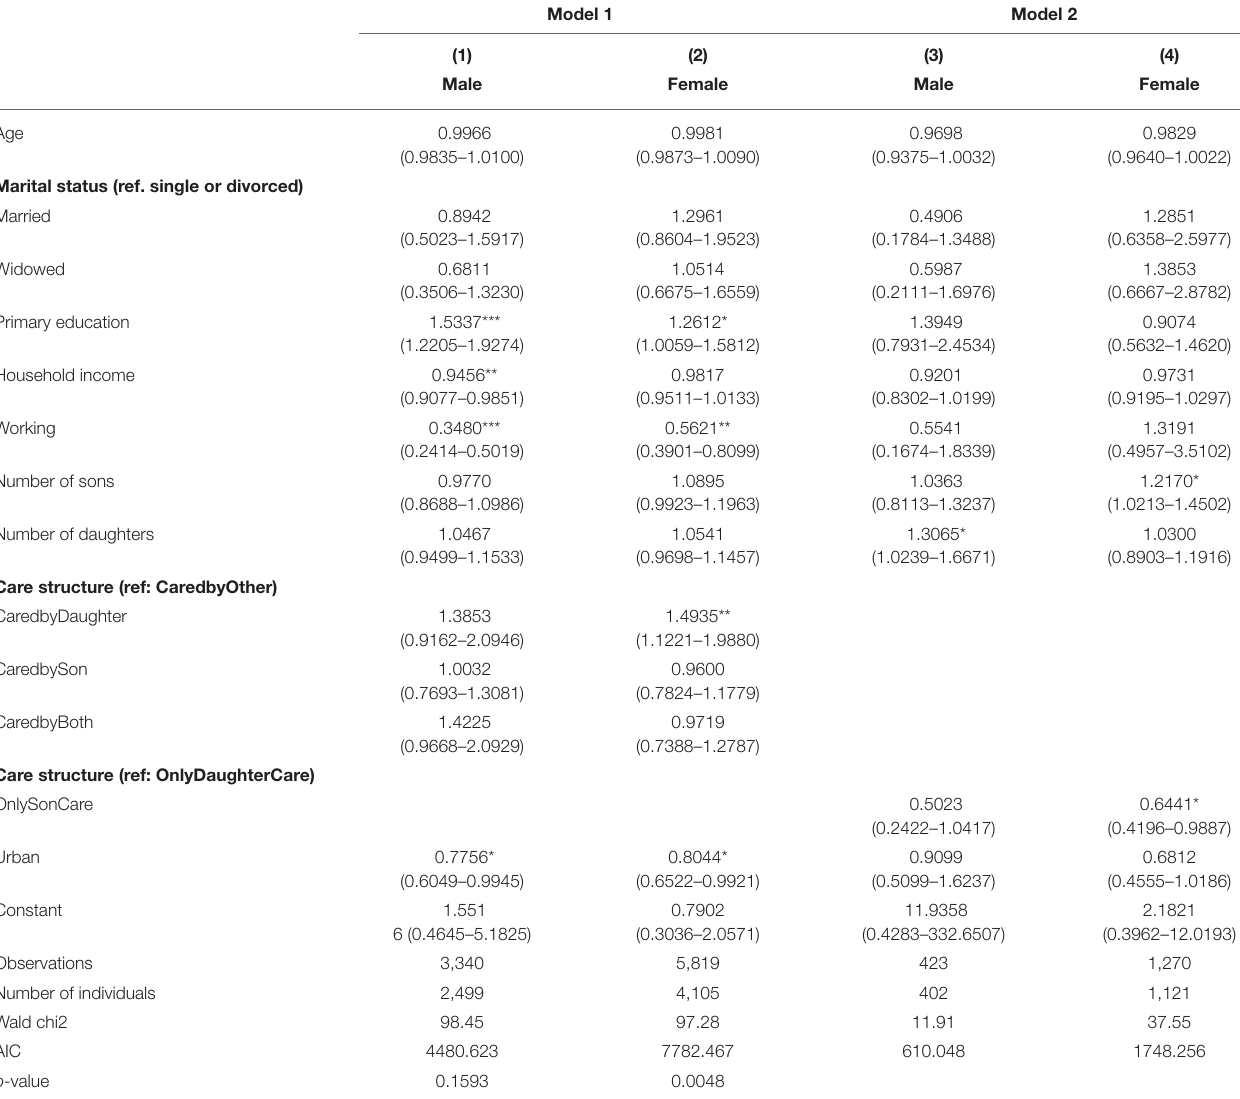
TABLE 5 | Radom-effects logistic regression models for self-reported health and care provided by son and daughter: differentiating by